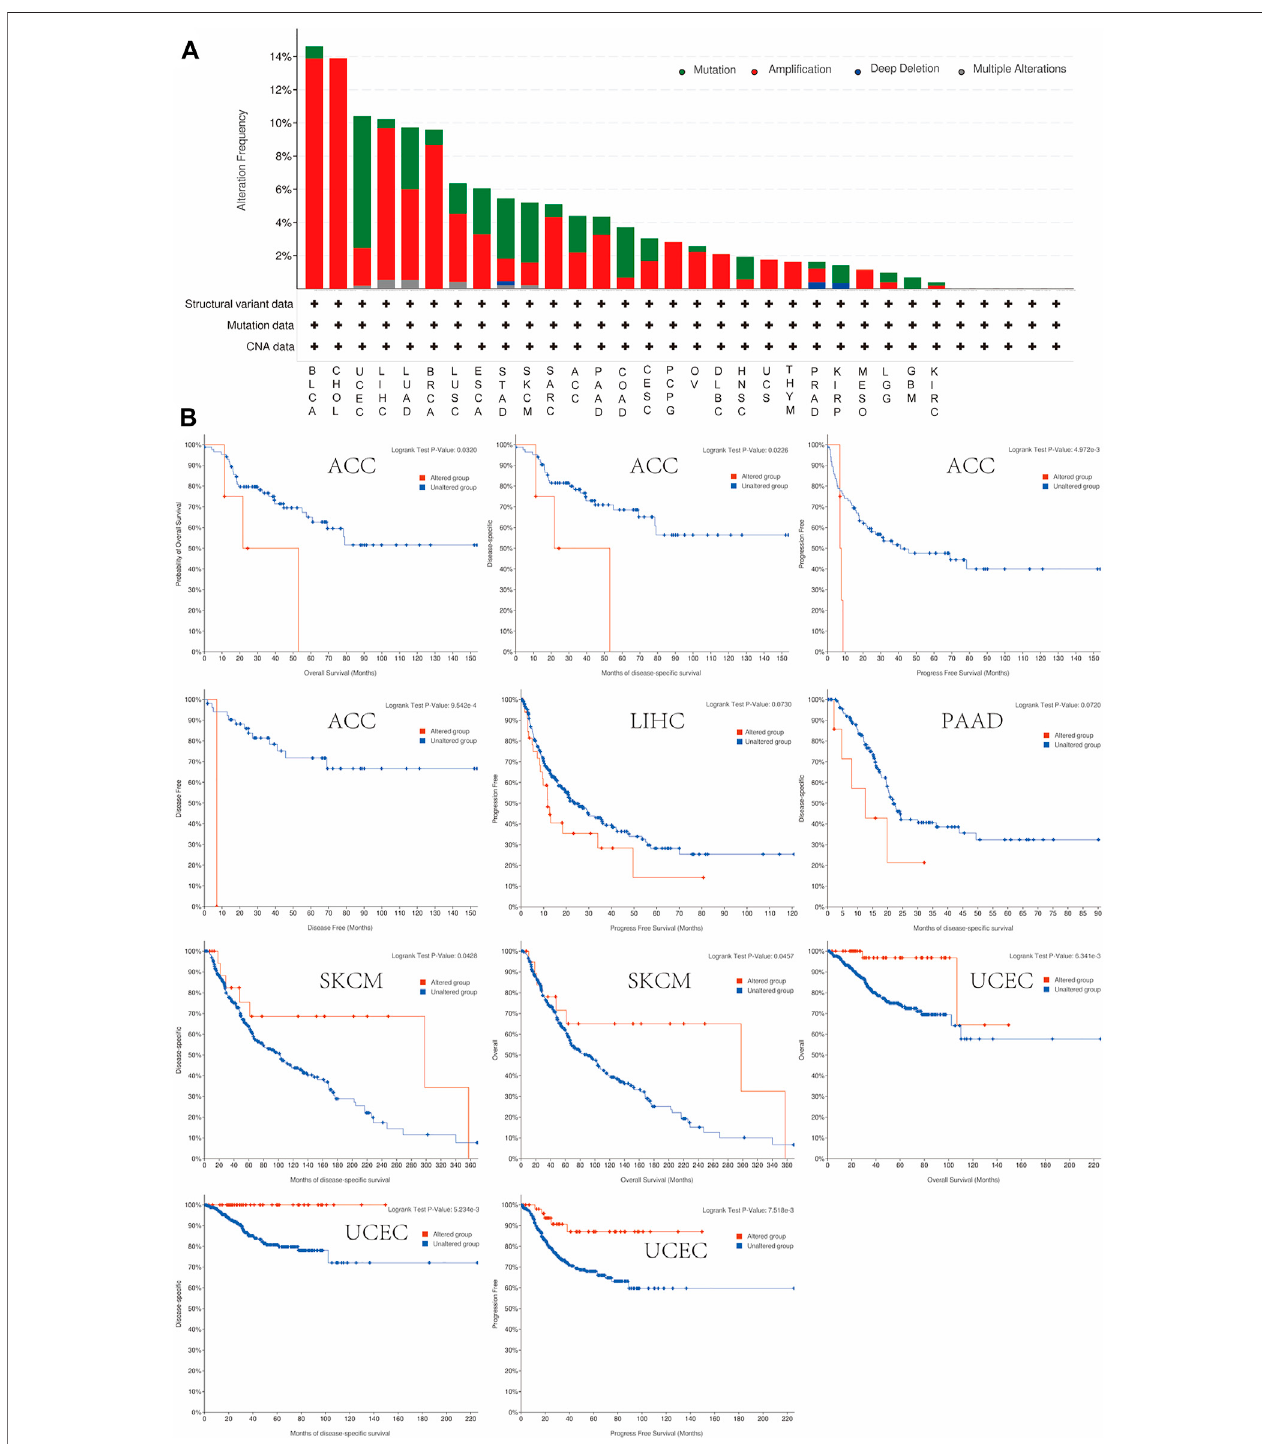
FIGURE 5 | Mutation feature of OLFML2B in pan-cancer. (A) Mutation status of OLFML2B in pan-cancer. (B) Correlation between the prognosis and alteration in ACC, LIHC, SKCM, and UCEC.